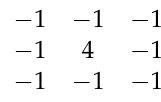
Figure A4. Histograms showing the probability distributions of the EPW values for the rear part of the real LV (up) and the synthetic object (down). The mean and standard deviation as obtained after rendering the scene for the synthetic object are adjusted to resemble those of the LV.